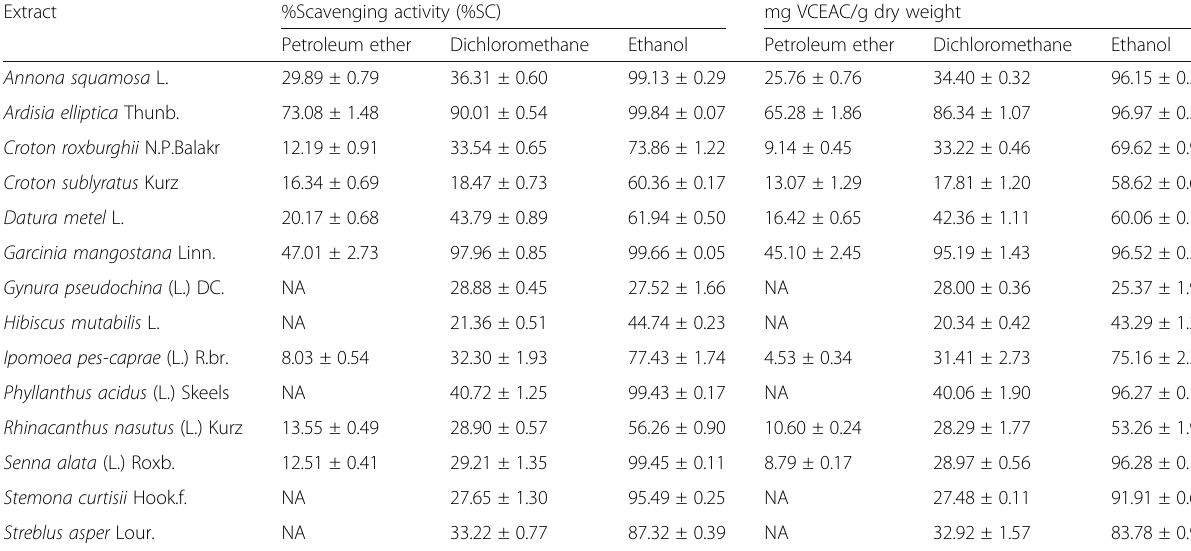
Table 4 Scavenging activity by ABTS assay